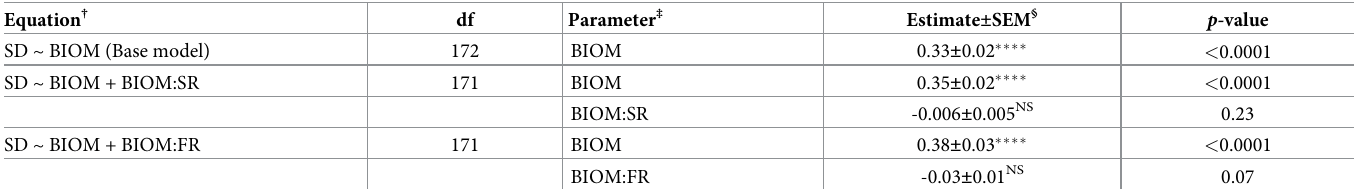
Table 6. Parameter estimates, degrees of freedom, and p -values for linear models relating standard deviation of cover crop biomass (SD) to mean cover crop above- ground biomass (BIOM) with and without cover crop species richness (SR) and functional richness (FR) interacting with cover crop aboveground biomass. A signif- icant value of BIOM:SR or BIOM:FR shows that species or functional richness, respectively, affects the relationship between SD and mean cover crop biomass.